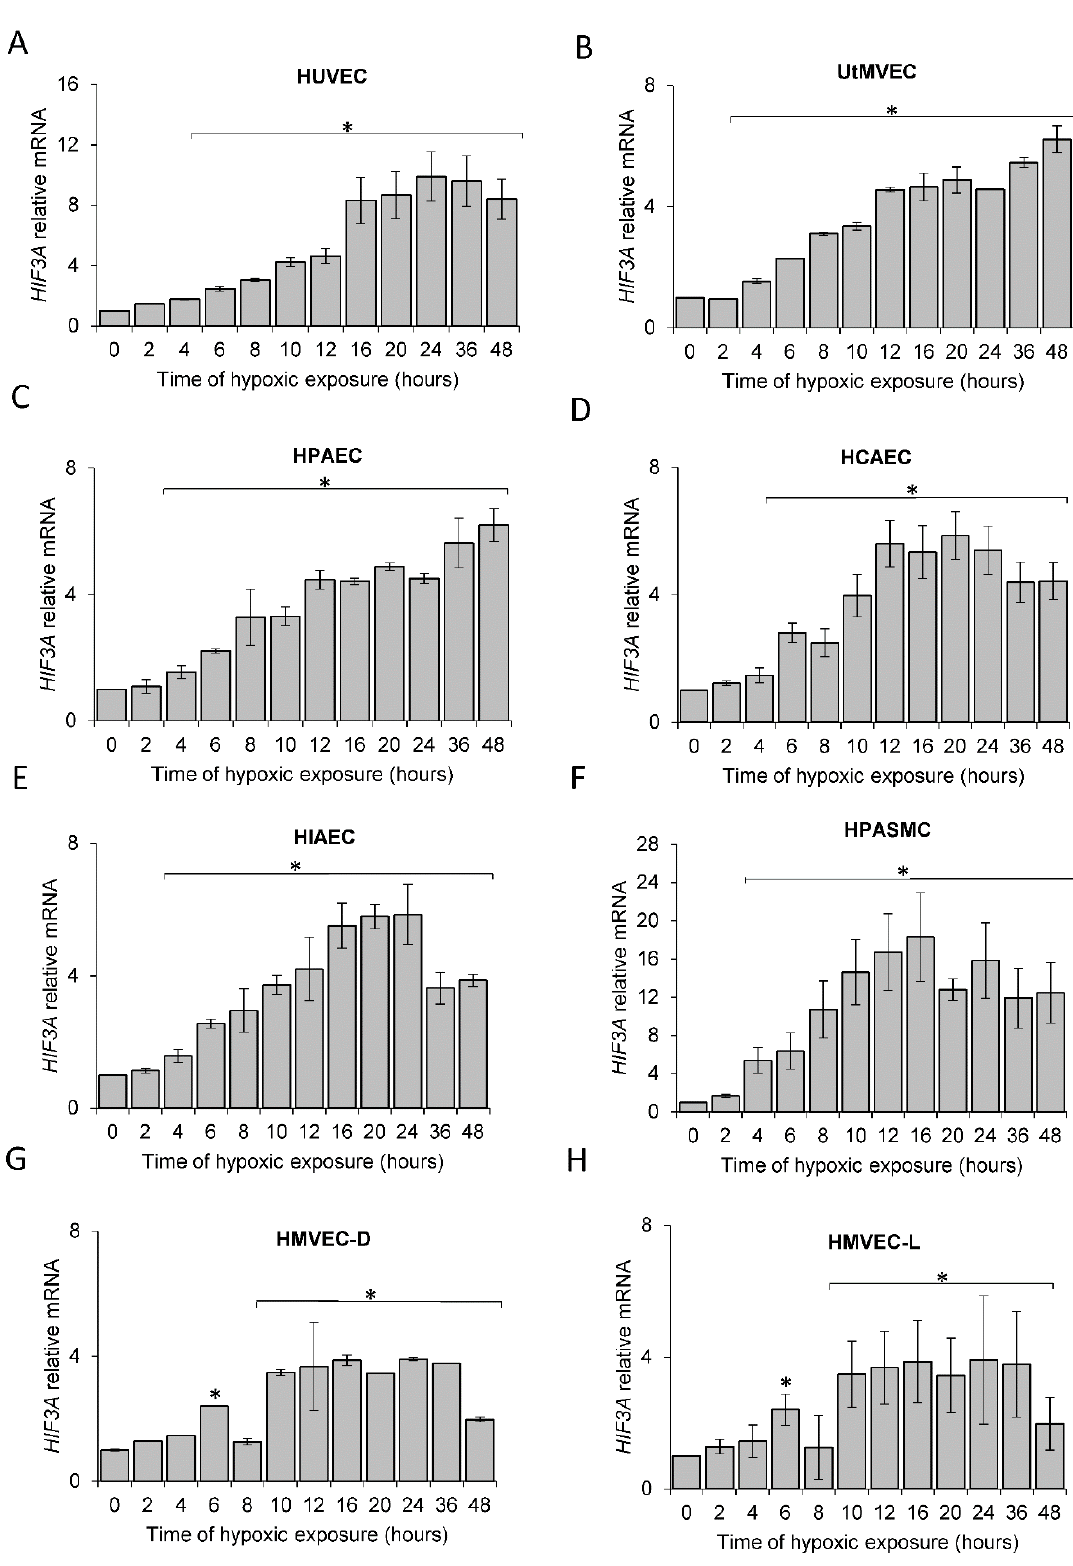
Figure 3: Hypoxia induces HIF3A mRNA levels in human ECs. Cells were exposed to hypoxia for the time periods specified and total RNA lysates were collected. HIF3A mRNA levels were quantified by qRT-PCR and normalized to TBP and RPLP0 RNA levels and expressed as a fold change over normoxic samples. Data represent the mean ± SD of three independent experiments. * P < 0.05 was considered significant. The raw data are presented in Supplementary data